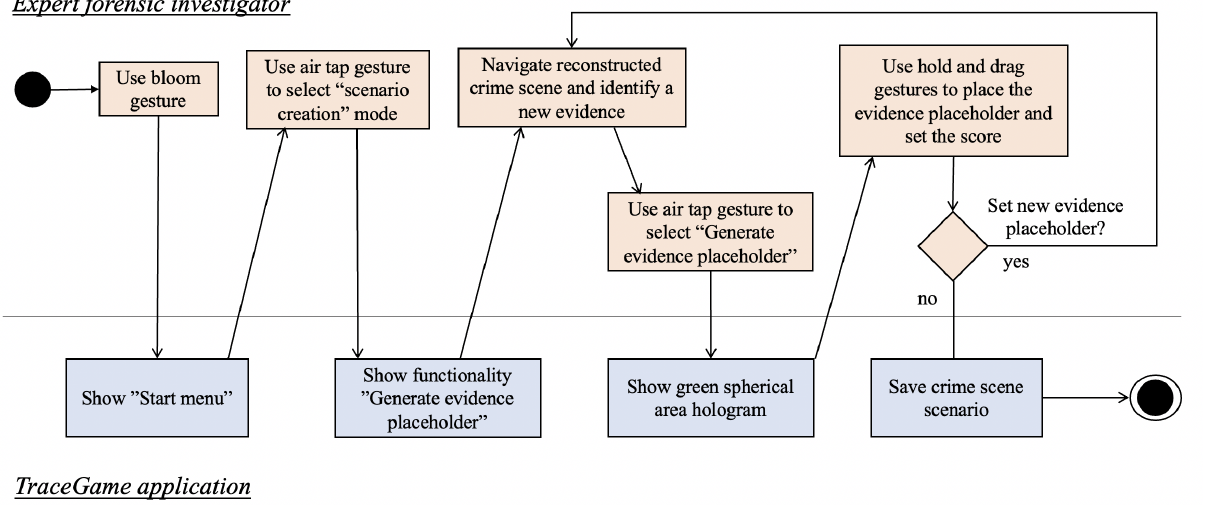
Figure 4. Activity diagram for the scenario creation user mode in